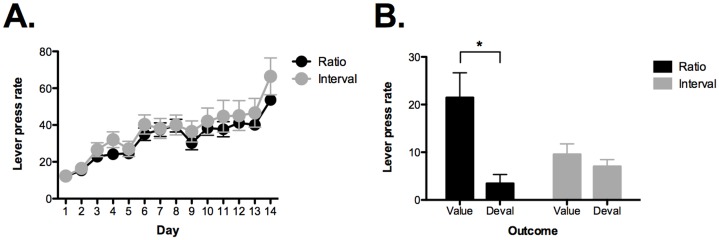
Interval training leads to habitual responding.A) Mice were trained to lever press for food pellets across 14 days. On days 1–2 the ratio group was trained on a RR5 schedule while the interval group was trained on a RI15 schedule. On days 3–4 the ratio group was trained on a RR10 schedule while the interval group was trained on a RI30 schedule. On days 5–14 the ratio group was trained on a RR20 schedule while the interval group was trained on a RI60 schedule. Both groups showed an increase in responding across training days. B) Mice trained on RR schedules showed a selective reduction in responding on the lever leading to the devalued outcome indicating that behavior was goal-directed. Mice trained on RI schedule did not exhibit a selective reduction in responding indicating that behavior was habitual. Error bars represent ± SEM. *p<0.05.